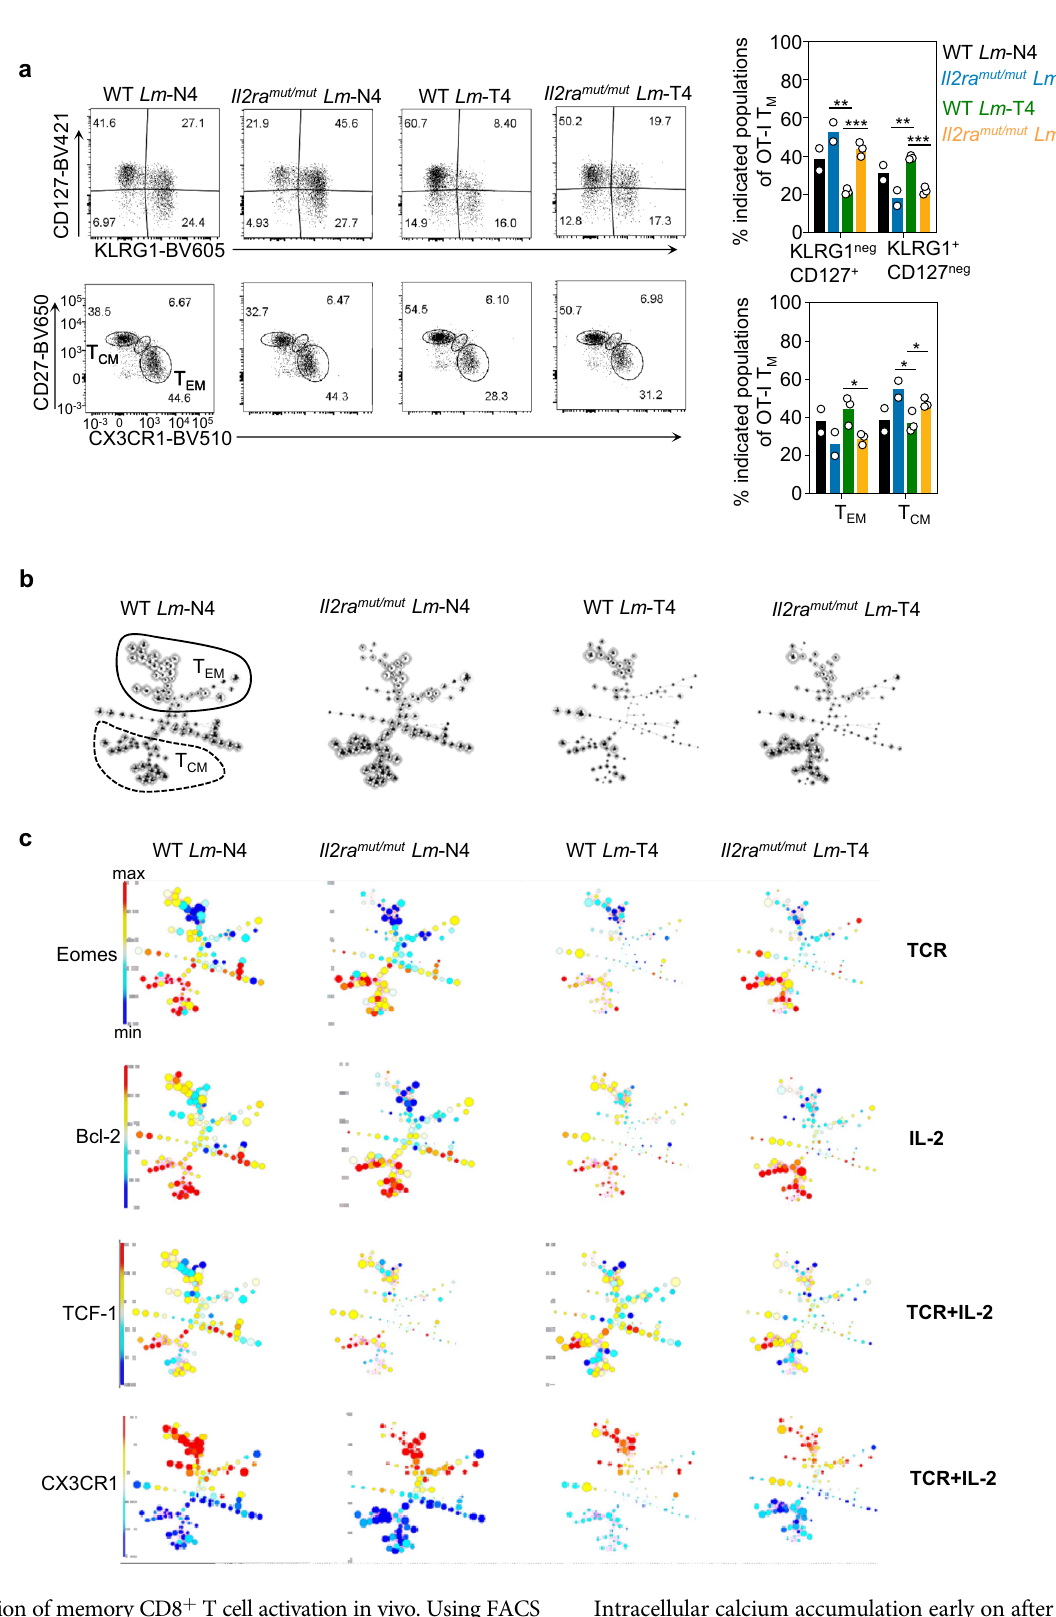
modulation of memory CD8 + T cell activation in vivo. Using FACS analysis, we tested whether WT or Il2ra mut/mut OT-I memory cells induced upon immunization with Lm -expressing weak (T4) or strong (N4) Ova APLs, exhibited different abilities to undergo rapid intracellular calcium signaling, enter cell cycle (16 h), and expand (day 4, 6, 9 and 12) after Lm -N4 challenge infection (Fig. 8a).